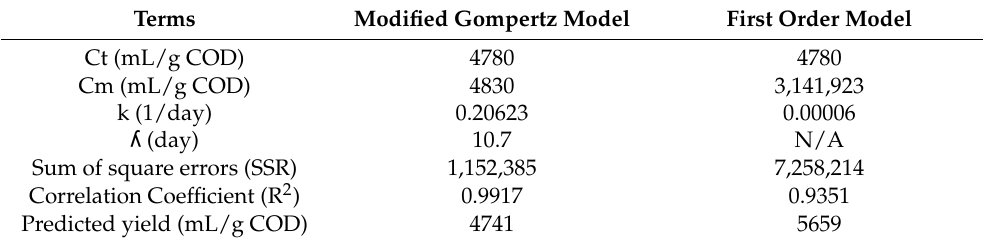
Table 2. A summary of the modified Gompertz and first order kinetic models for the BP system.